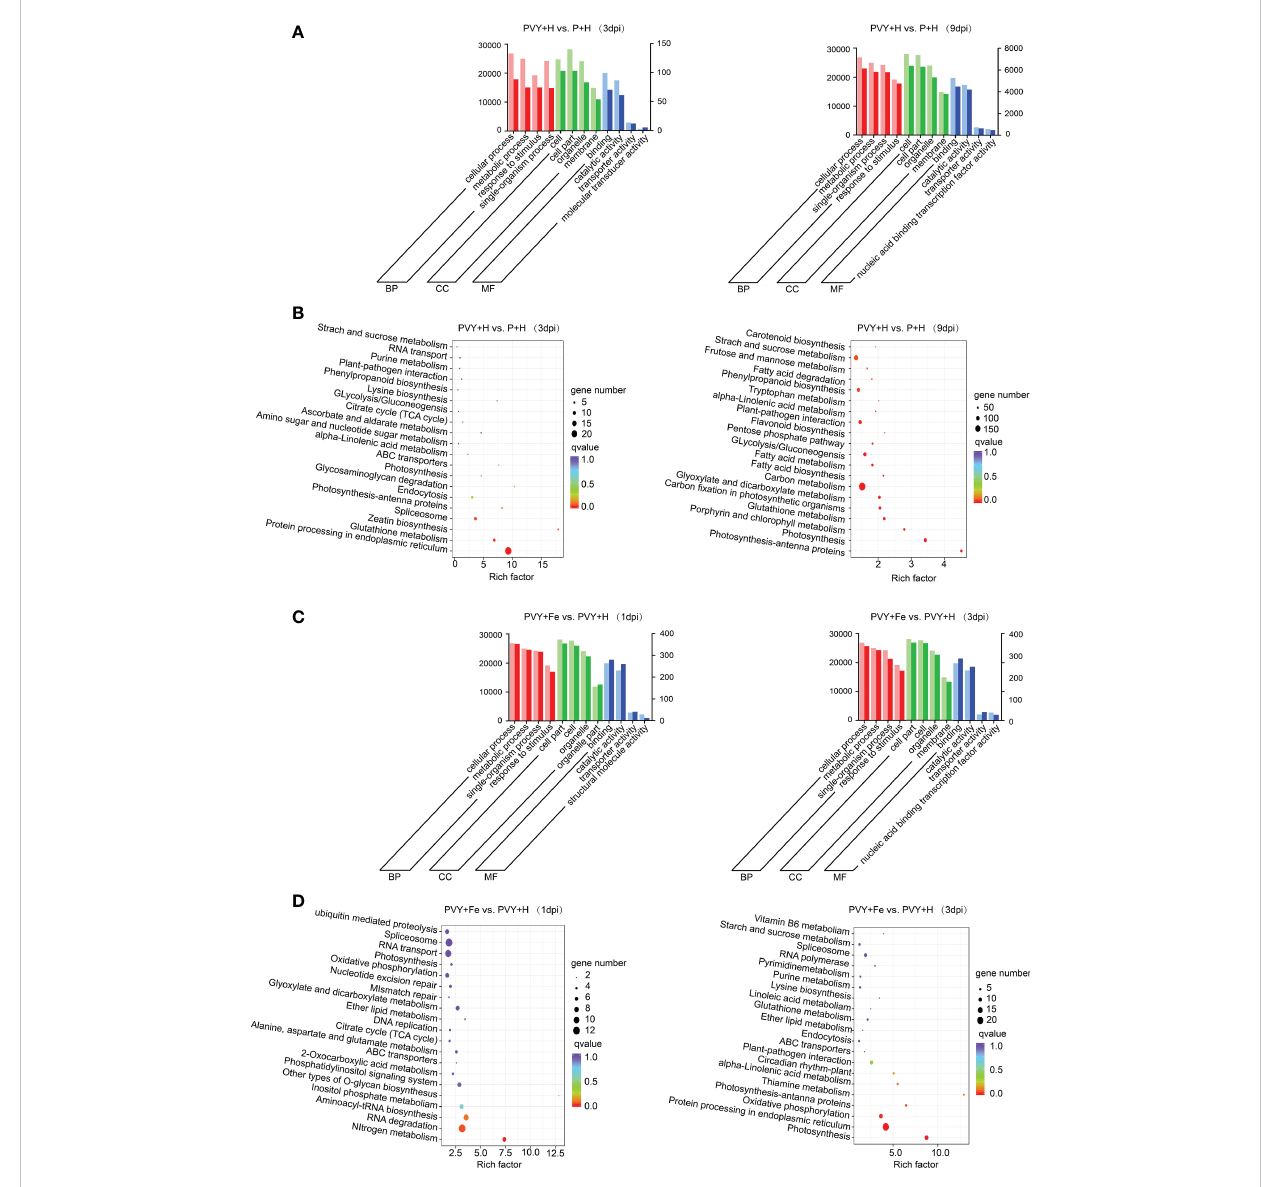
FIGURE 5 GO and KEGG enrichment analyses of DEGs. (A) GO analyses of DEGs in PVY + H vs. P + H at 3 and 9 dpi. (B) KEGG enrichment analyses of DEGs in PVY + H vs. P + H at 3 and 9 dpi. (C) GO analyses of DEGs in PVY + Fe vs. PVY + H at 1 and 3 dpi. (D) KEGG enrichment analyses of DEGs in PVY + Fe vs. PVY + H at 1 and 3